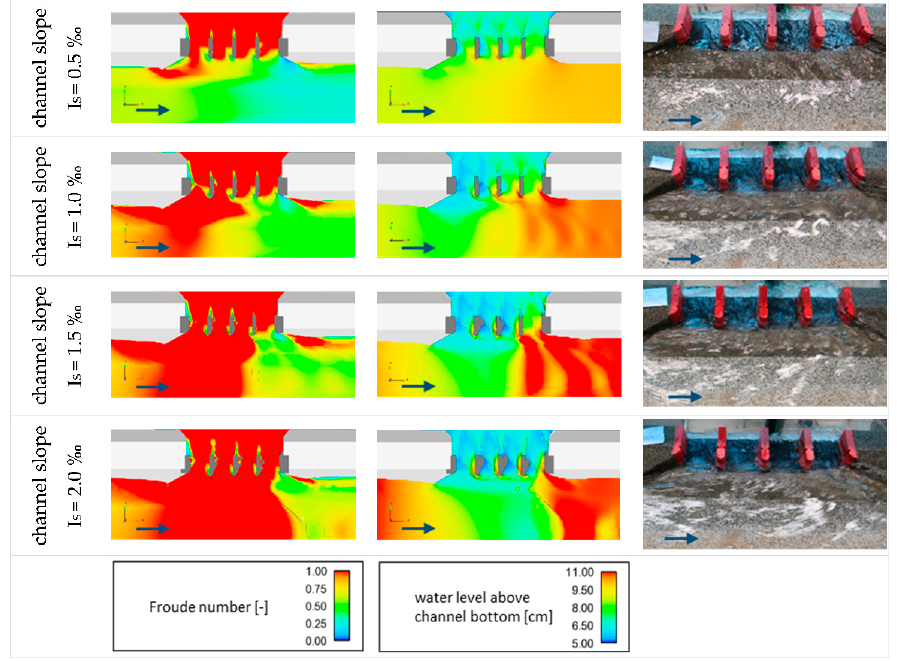
Figure 10. Plots of the Froude number and the flow depths in the numerical model as well as pho- tos of the physical model in the configuration with all weir fields (4) opened for channel slopes of 0.5–2.0‰; flow direction from left to